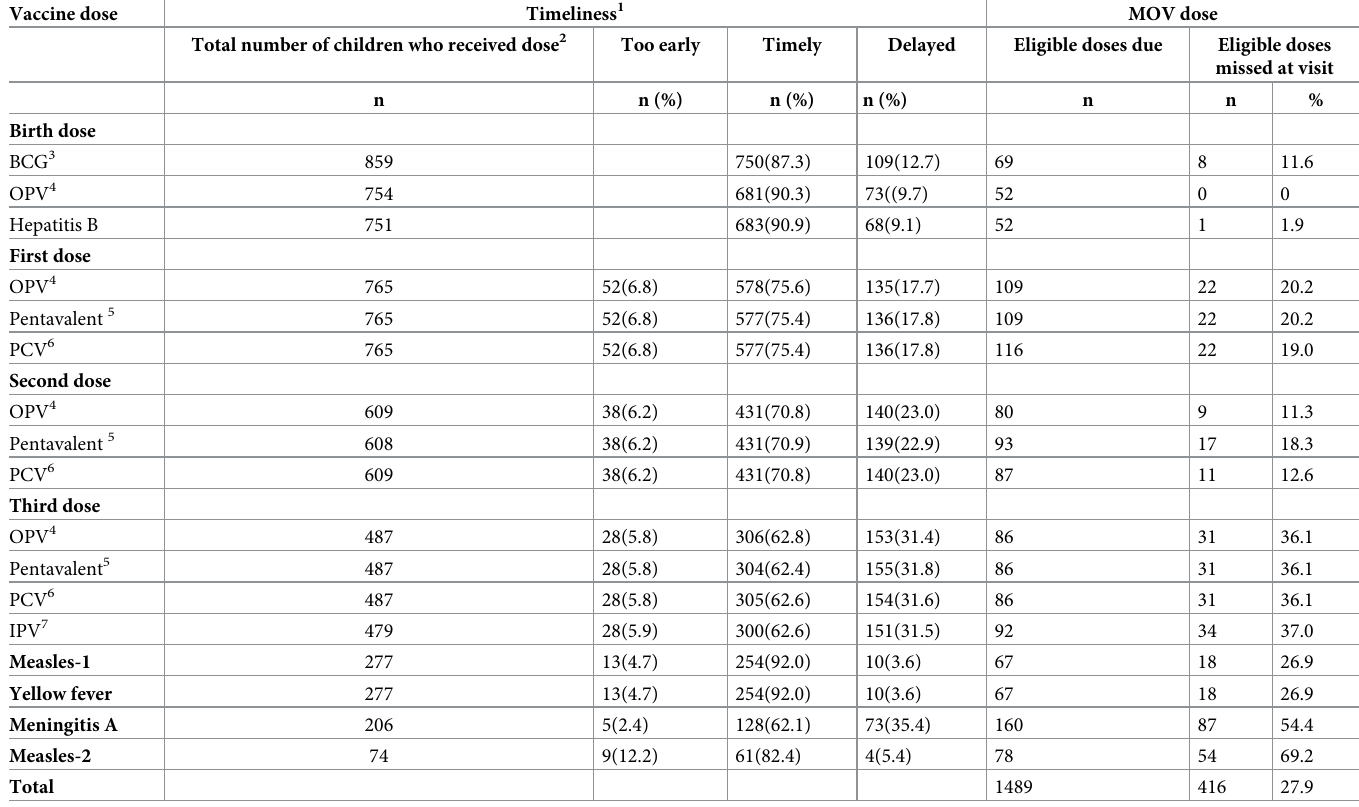
Table 5. Timeliness of vaccination administered and missed opportunities by dose among children aged 0–23 months surveyed during a Missed Opportunities for Vaccination (MOV) assessment with documented vaccination histories, Ondo State, Nigeria,